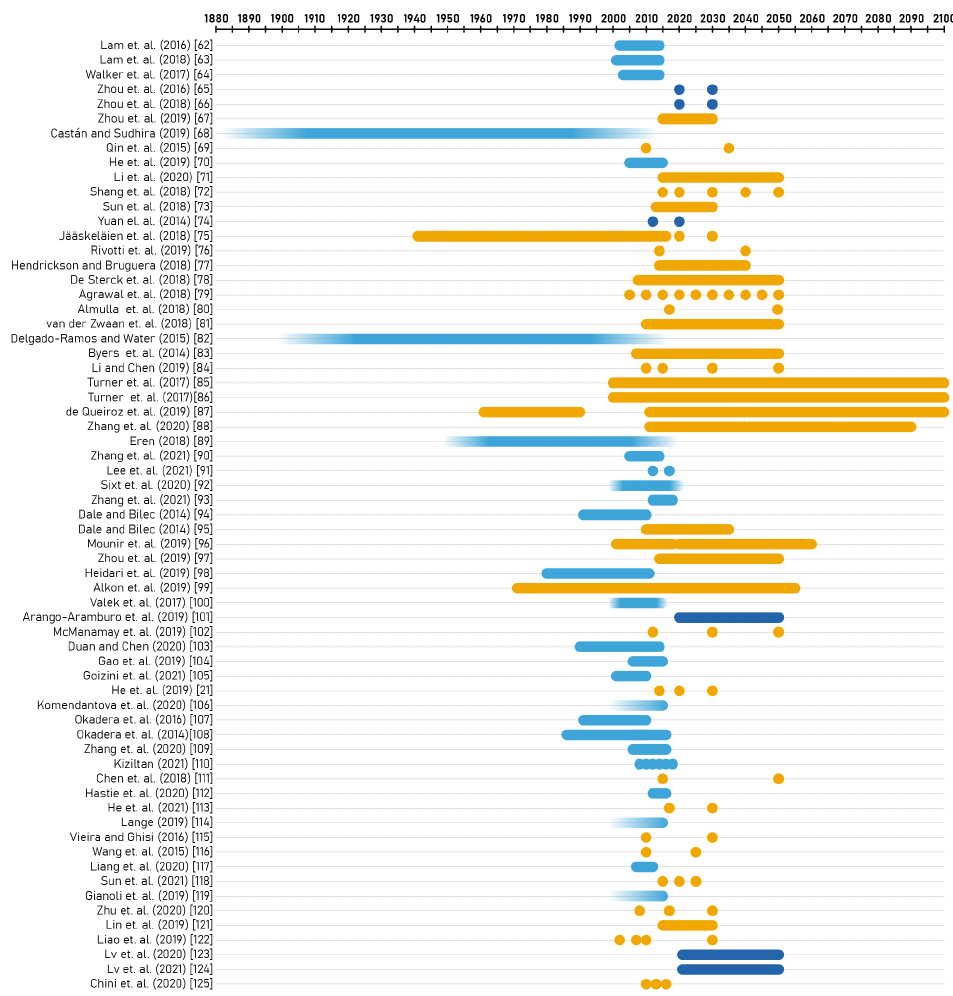
Figure 6. Distribution of analyzed periods. Past periods are presented in light blue, past and future periods in orange, and future periods in dark blue